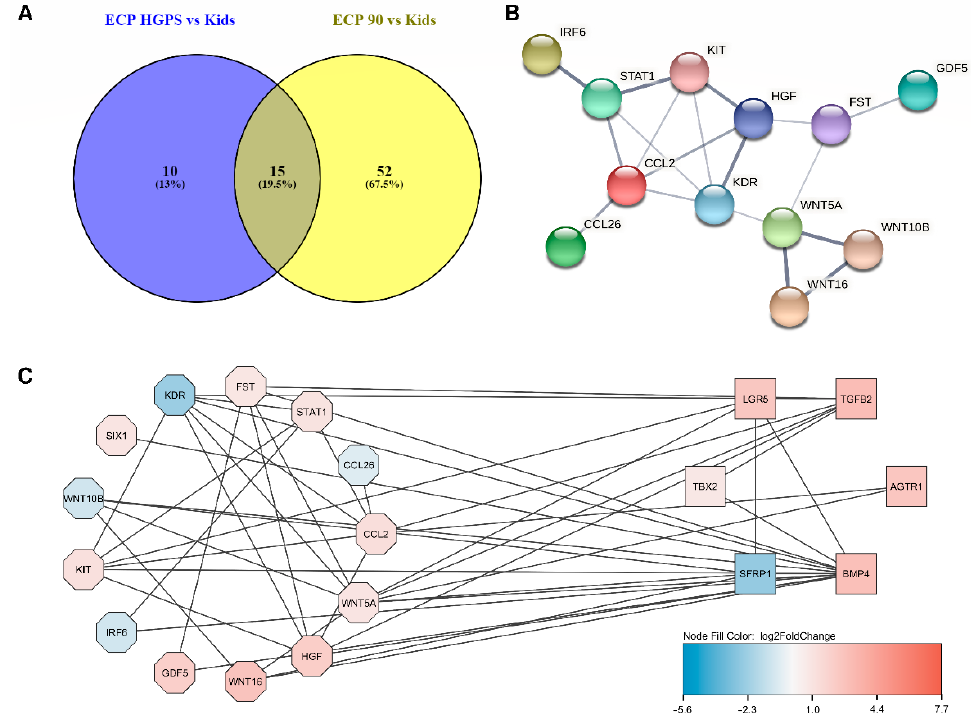
Figure 4. Comparison of accelerated and natural aging. ( A ) The visualization of the DEGs involved in Epithelial Cell Proliferation (ECP) differentially expressed in HGPS (blue) and old age (yellow) shows that both have 15 DEGs in common. ( B ) The common DEGs of old age and HGPS involved in ECP are visualized as STRING network (applying fullstringnetwork medium confidence of 0.4). ( C ) Visualization of the DEGs involved in ECP (by using STRING database and Cytoscape): common DEGs (octagons) and DEGs specific for HGPS (rectangles) and the respective log2foldchanges (blue downregulated, red upregulated).